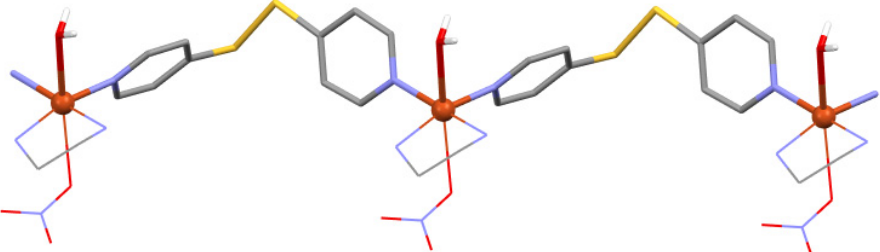
Figure 12. Arched chain in [{Cu(NO showing the right-handed P form of dtdp and the left-handed λ form of the Cu(en) 2+